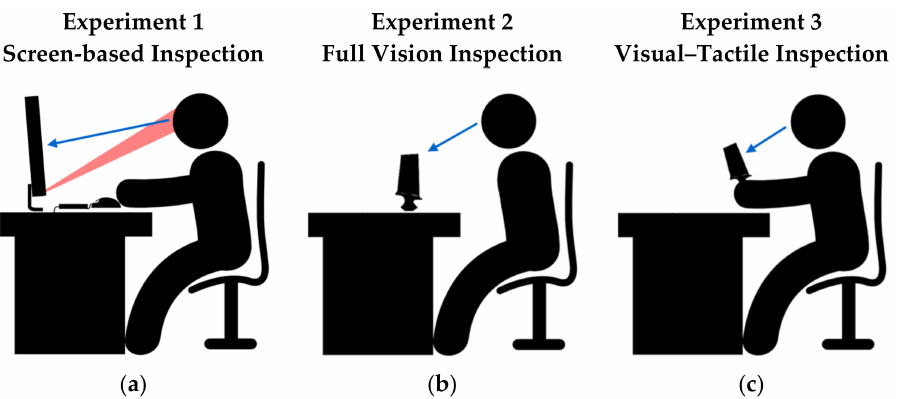
Figure 2. Three experiments representing three inspection methods: ( a ) screen-based inspection, in which the part was presented on a computer monitor; ( b ) part-based inspection, with full vision of the blade from all angles and distances; ( c ) visual–tactile inspection of the part, allowing the use of the sense of touch additionally to